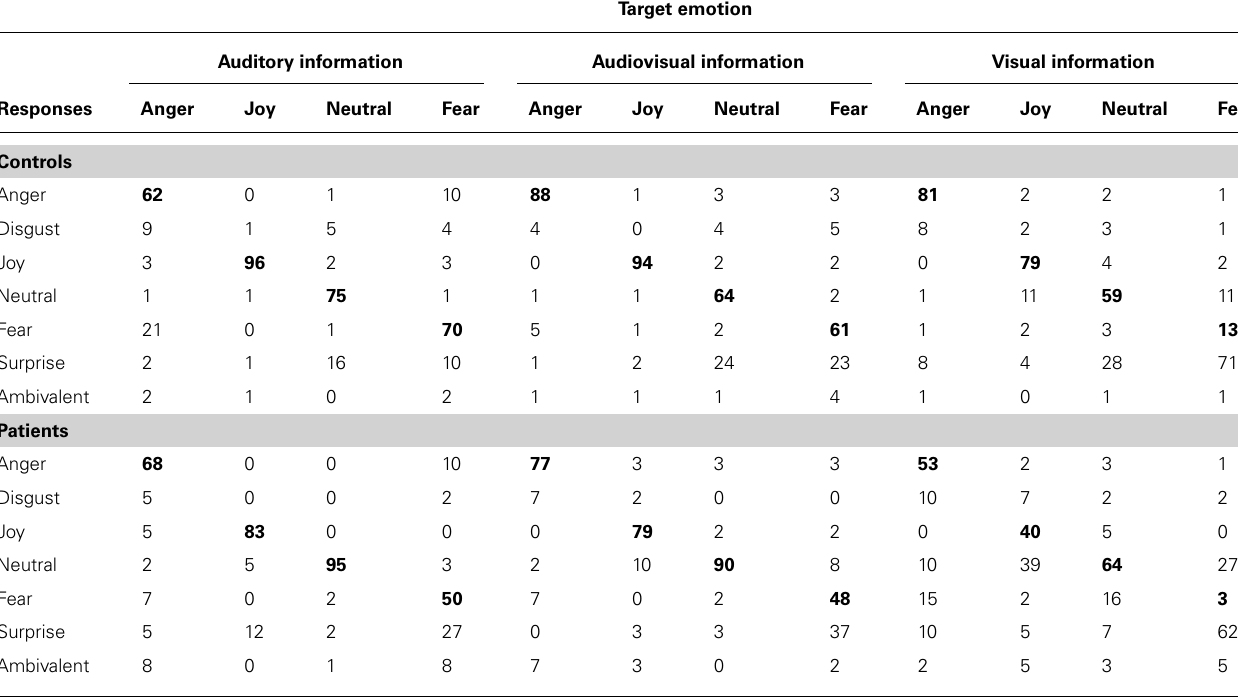
Table 3 | Confusion